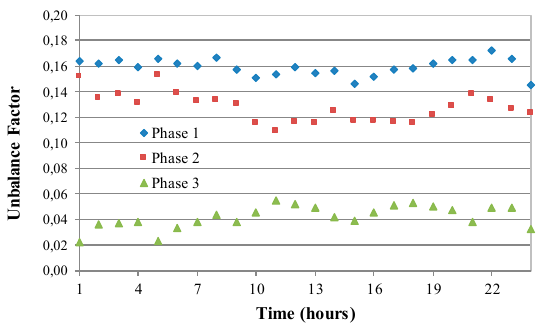
Figure 9. Initial unbalance factors for all periods, Bariloche.